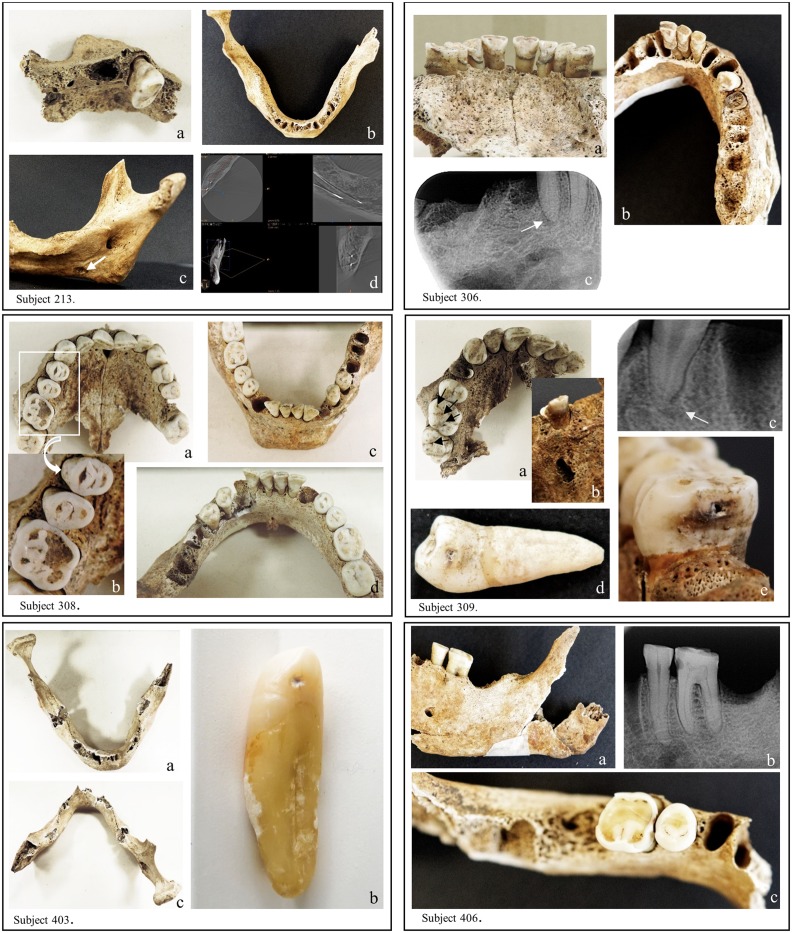
Photographs, X-ray and Cone Beam Computed Tomography (CBCT) of maxilla and mandible from sampled subjects.(Subject 213) a: maxillary septal region showing sharp, ragged aspect on both sides of tooth 14; b: deformation of the mandibular cortical bone on the right part of the horizontal branch; c: inner part of the mandibular right horizontal branch showing a fistula aperture (indicated by a white arrow); d: CBCT examination differentiating the fistula’s pathway and the inferior alveolar nerve pathway. (Subject 306) a: maxillary teeth presenting significant deposits of dental calculus; b: disorganized and riddled posterior mandibular septal morphology and destruction of the crown part of tooth 45; c: X-ray view of a granuloma on the apical part of tooth 45 (indicated by a white arrow). (Subject 308) a; c and d: sound teeth, maxillary and mandibular bones (dental calculus presents on lingual tables of teeth 31 ad 41; b: focus on important dental wear on teeth 14; 15 and 16. (Subject 309) a: groove decay on the occlusal tables of maxillary teeth 16 and 17 (indicated by black arrows); b: vestibular fenestration of the maxilla in front of the root apex of tooth 14; c: radiologically visible periapical cyst on the apex of tooth 14 (indicated by a white arrow); d: decay on the distal table of tooth 34; e: decay on the mesial table of tooth 46. (Subject 403) a and c: no teeth on the mandibular arch (except tooth 43 which was sampled for analysis); b: closer view of tooth 43 showing a small patch of distal decay. (Subject 406) a: external view of the left horizontal mandibular branch supporting teeth 35 and 36; b: retroalveolar X-ray image highlighting decay on distal table of tooth 35 and mesial table of tooth 36; c: occlusal view of teeth 35 and 36 revealing dental coloration due to the decay process between the two teeth. Pictures realized and assembled by C. Willmann.